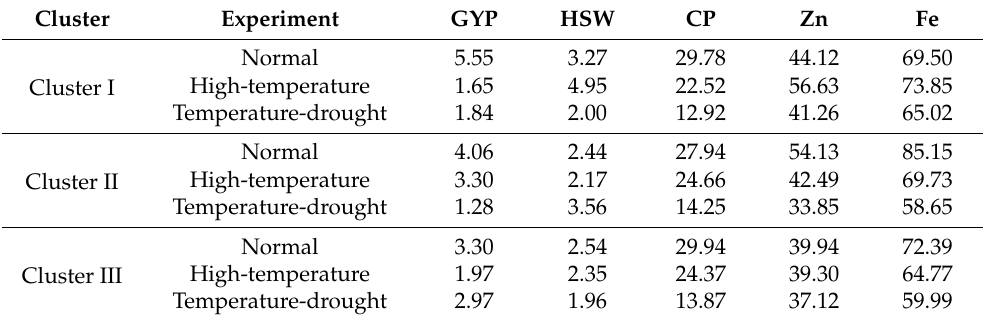
Table 3. Grain yield, hundred-seed weight, crude protein, zinc content and iron content of the three clusters for normal, temperature stress and combined temperature-drought stress.